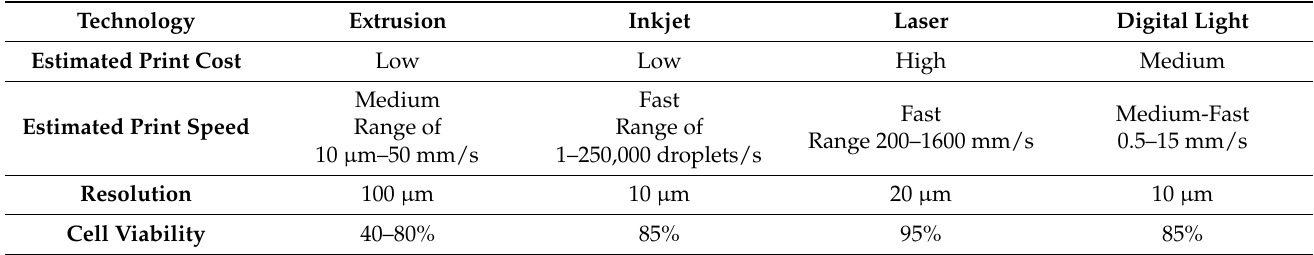
Table 1. Summary of Bioprinting Technologies